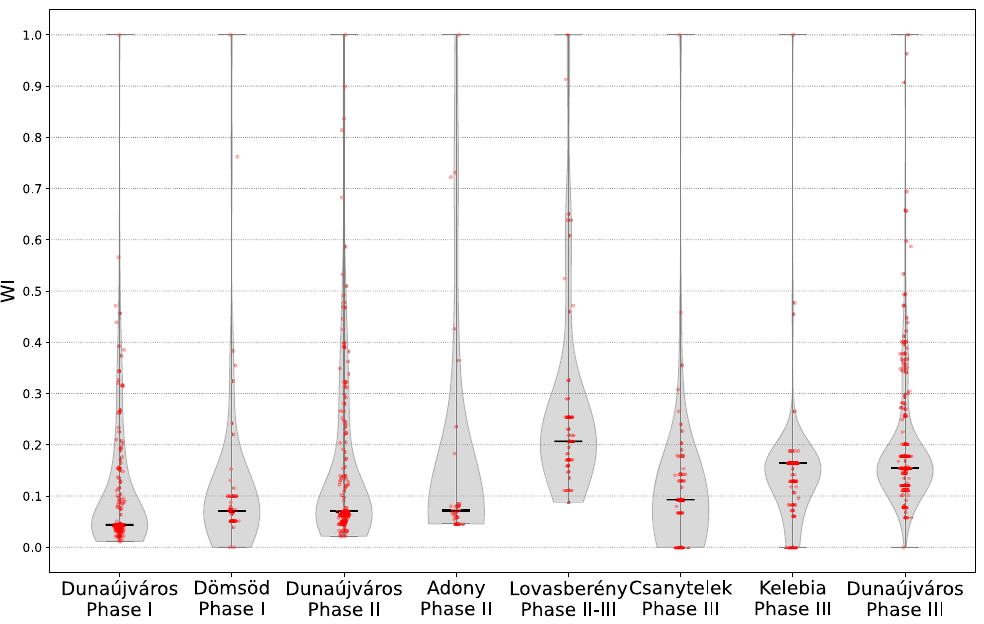
Figure 11: Comparison of the WI distribution of Vatya cemeteries Phase I to III ( c. 2200 – 1450 BCE ) . Bold black bars indicate the